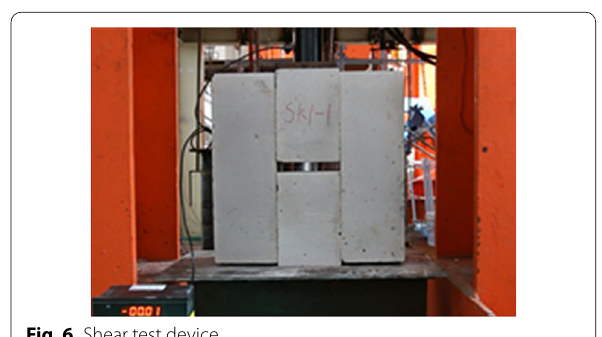
Fig. 6 Shear test